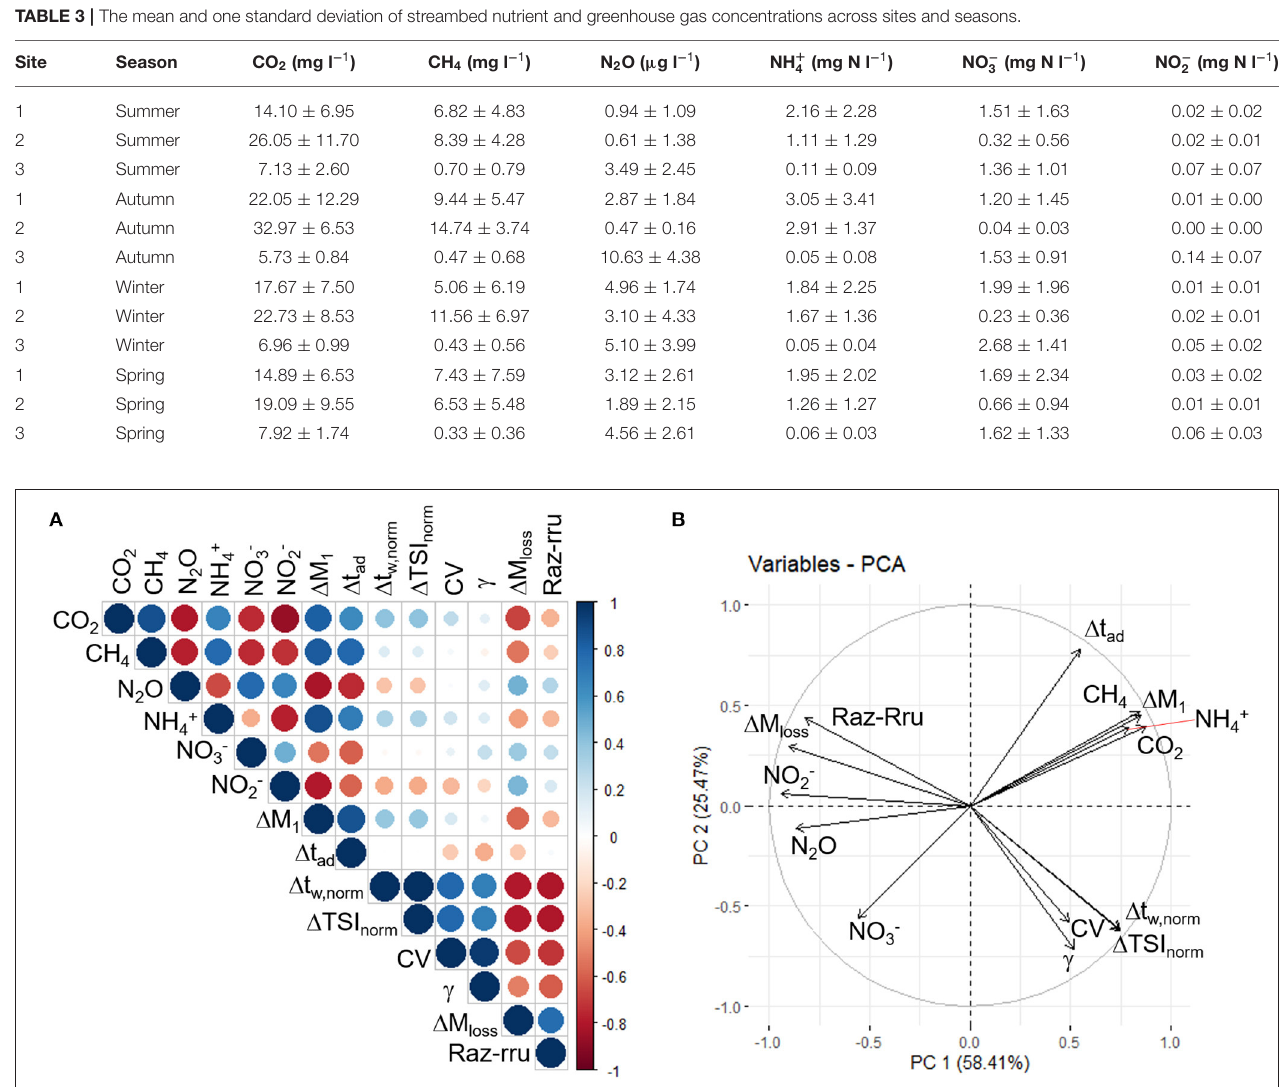
FIGURE 3 | (A) A plot of the spearman rank correlation coefficients for all hydrological and chemical parameters. The correlation is indicated by color and circle size where blue indicates a positive correlation and red indicates a negative correlation, with the gradient of color indicating the strength of the correlation. The strength of the correlation is further indicated by circle size. Plots of the data for each of the correlations, including whether they are significant, are presented in Supplementary Figures 6 – 12 . (B) The contribution of variables to principal component 1 and principal component 2